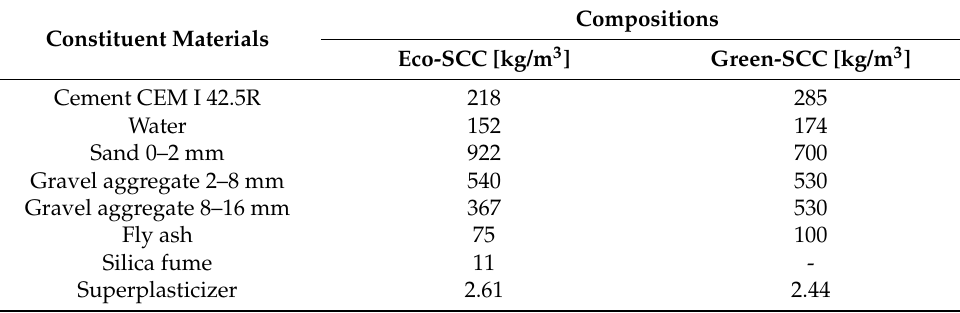
Table 1. Proportioning of investigated eco-efficient SCC mixtures for 1 cubic